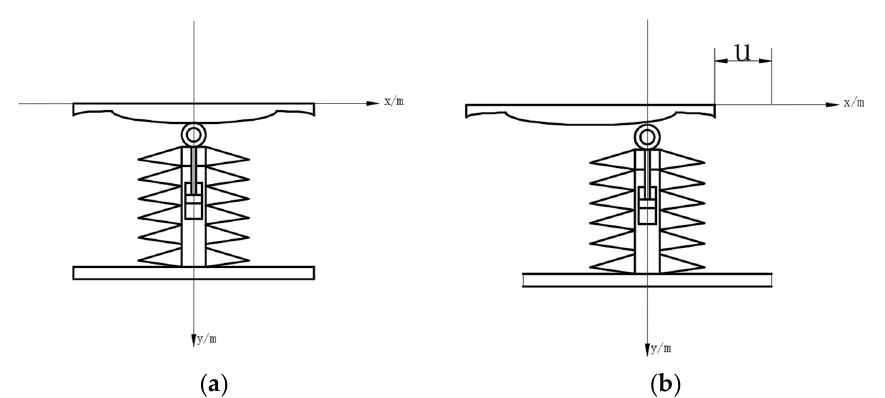
Figure 2. Motion state of negative-stiffness device. ( a ) Initial state of the device ( b ) Device state after horizontal displacement, u.